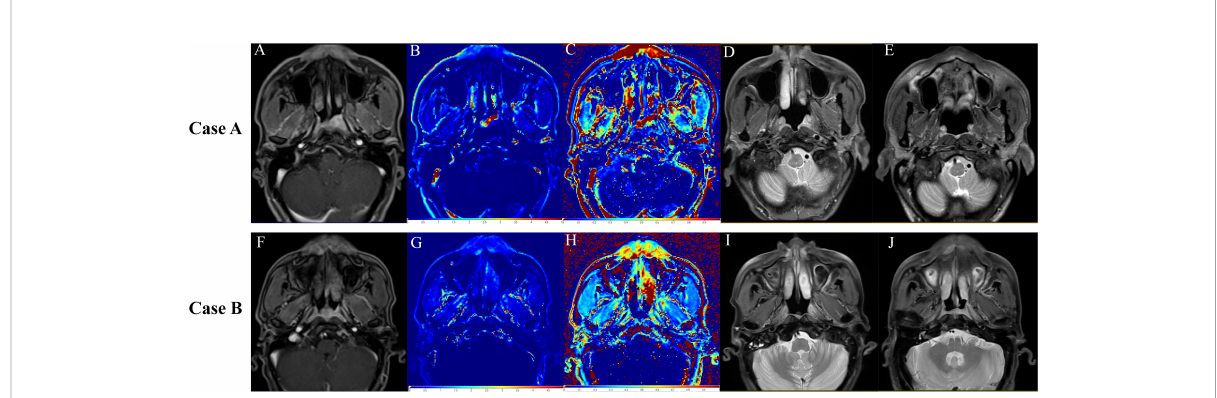
FIGURE 5 Representative images from three different time points during the follow-up period. The upper row shows images from Case A (T3N2M0) treated with nimotuzumab. (A – C) Baseline DCE-MR images. (A) Slice image. (B) k trans image. (C) v e image. (D) T2-weighted image at 3 months of follow-up showing shrinkage of the primary tumor lesion. (E) T2-weighted image at 23 months of follow-up showing complete regression of the primary tumor. The lower row shows images from Case B (T3N2M0) not treated with nimotuzumab. (F – H) Baseline DCE-MR images. (F)